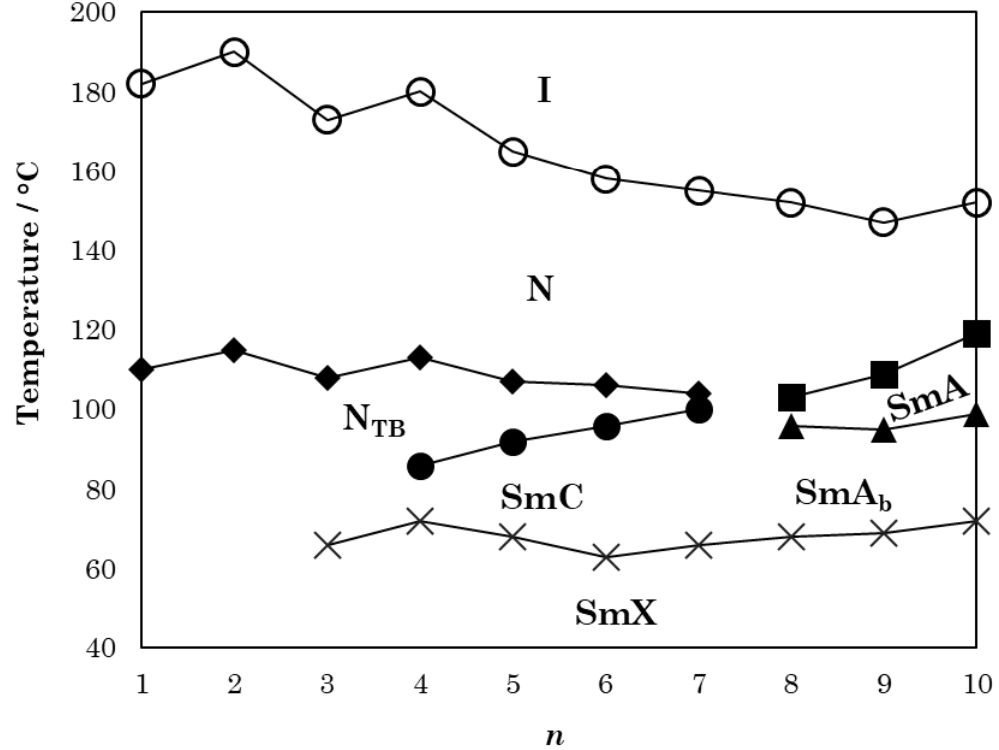
Figure 7. Dependence of phase behaviour of the CB6OBA: n OS on the length of the terminal alkyl chain, n , where ○ represents T N*I , ◼ T SmAN , ⯅ T SmAbSmA , ◆ T NTBN, ● T SmCNTB and ✕ T SmXSmC/Ab.